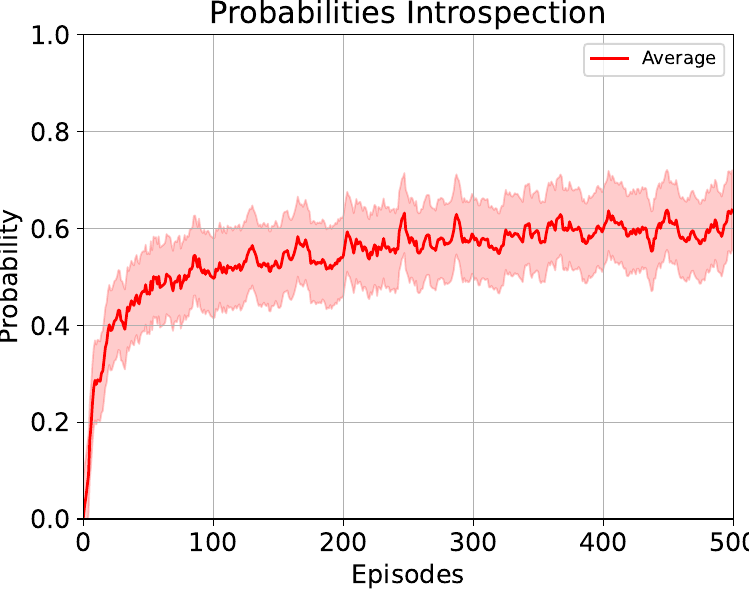
Figure 7. Average values for the probability of success for five runs of the agent’s training during 500 episodes using the introspection-based method proposed in Algorithm 2. The probability value is smoothed and the shaded area represents the standard